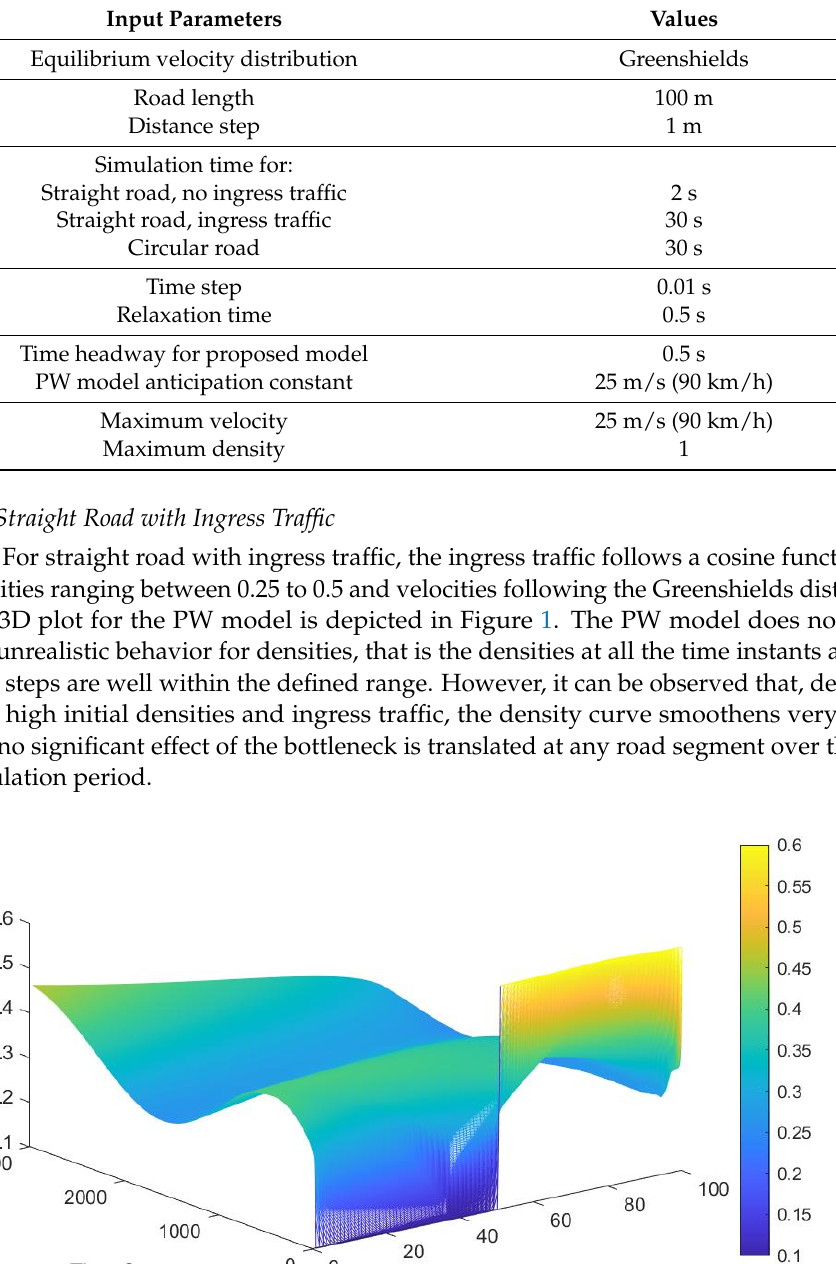
Figure 2. Velocity behavior of PW model on straight road with ingress traffic.